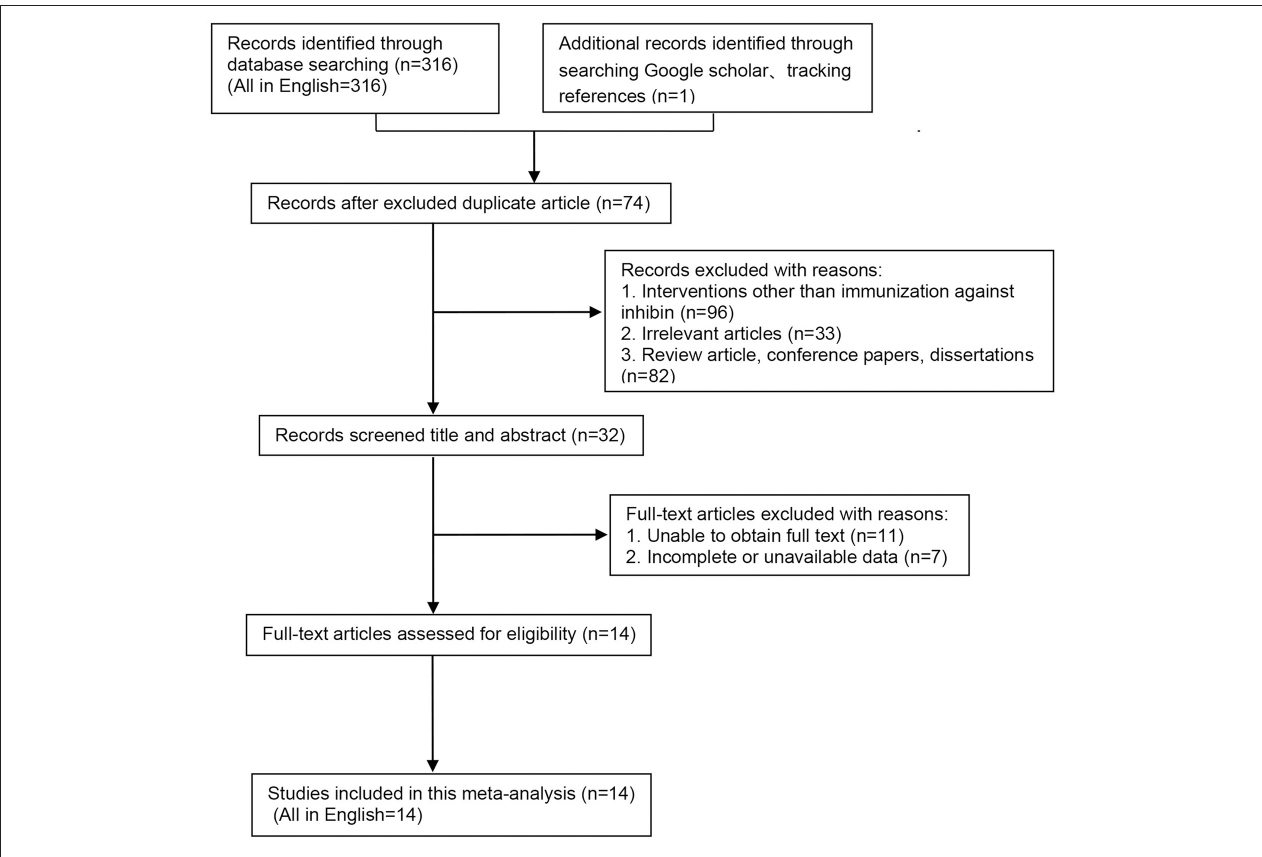
FIGURE 1 | Literature screening flow